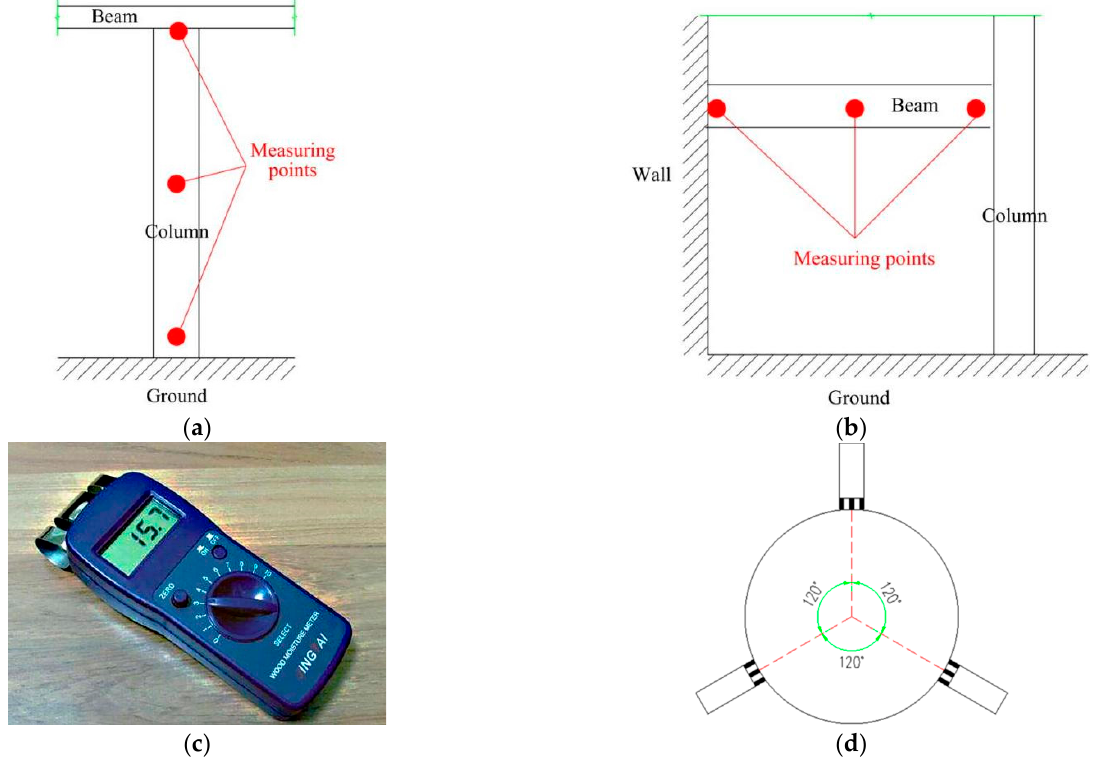
Figure 4. Moisture content detection method; ( a ) measuring points of column; ( b ) measuring points of beam; ( c ) wood moisture meter JK W10; ( d ) measuring points in the same cross-section plan of one component.